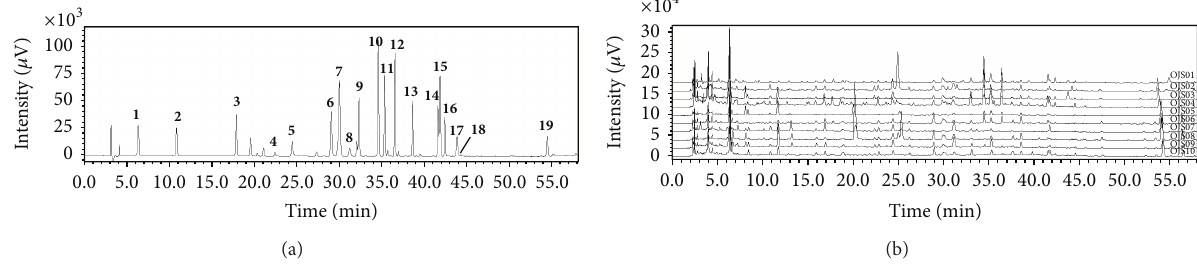
Figure2:Chromatogramsof(a)thestandardmarkercompoundsand(b)OJSsamplesatadetectionwavelengthofUV254 nm.( 1 )Gallicacid,